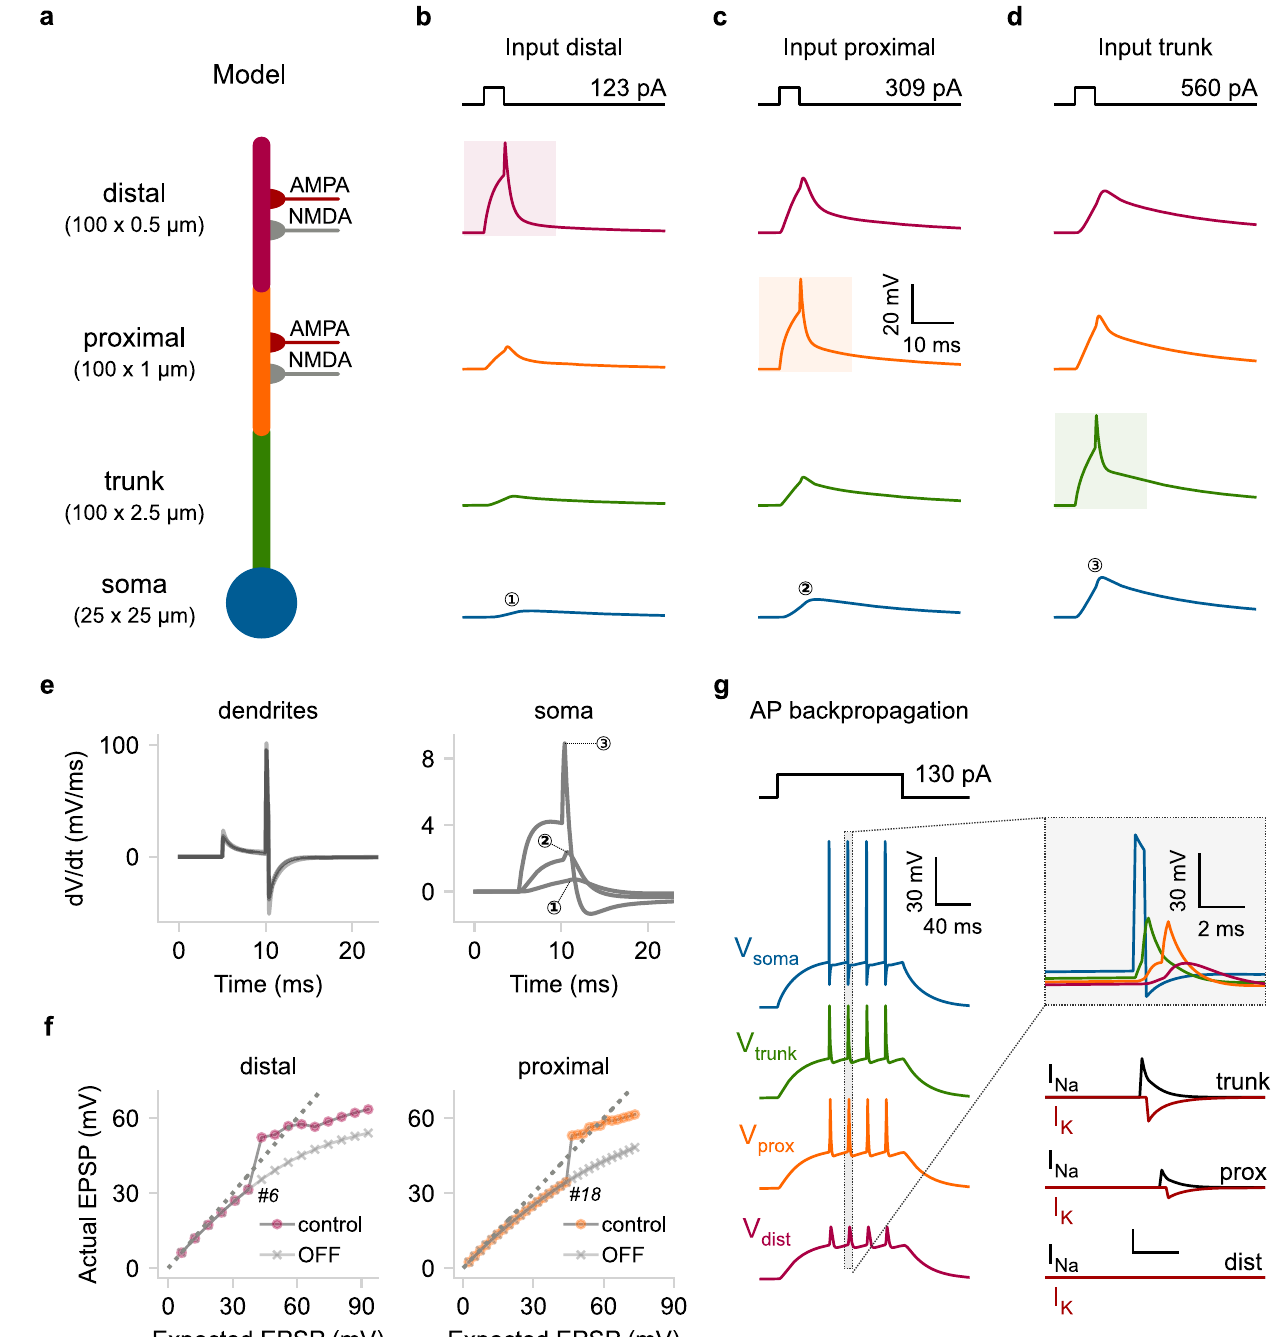
Fig. 3 | A reduced compartmental model that replicates active dendritic properties. a Schematic illustration of a compartmental model consisting of a soma (leaky I&F) and three dendritic segments (trunk, proximal, distal) equipped with Na + -type VGICs. The distaland proximalsegments can also receive AMPAand NMDA synapses. b – d Rheobase current injections (5ms square pulses) for dSpike generation were applied individually to each dendritic segment. Shaded areas: location of current injection and dSpike initiation. Top: stimulation protocol showing the current threshold for a single dSpike (rheobase current). e First tem- poral derivative of dendritic (left) and somatic (right) voltage traces from panels ( b – d ). f Input – output function of the distal (left) and proximal (right) segment as recordedfromthecorrespondingdendriticlocations.Wealsoindicatethenumber